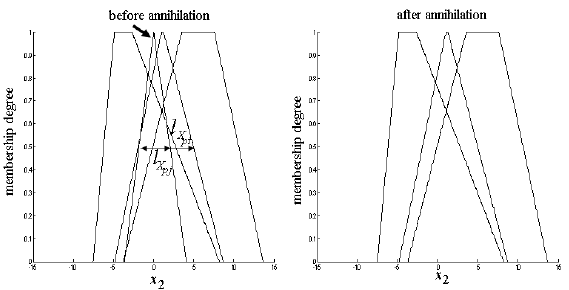
Fig. 9. Annihilation of a narrow FS (arrow)